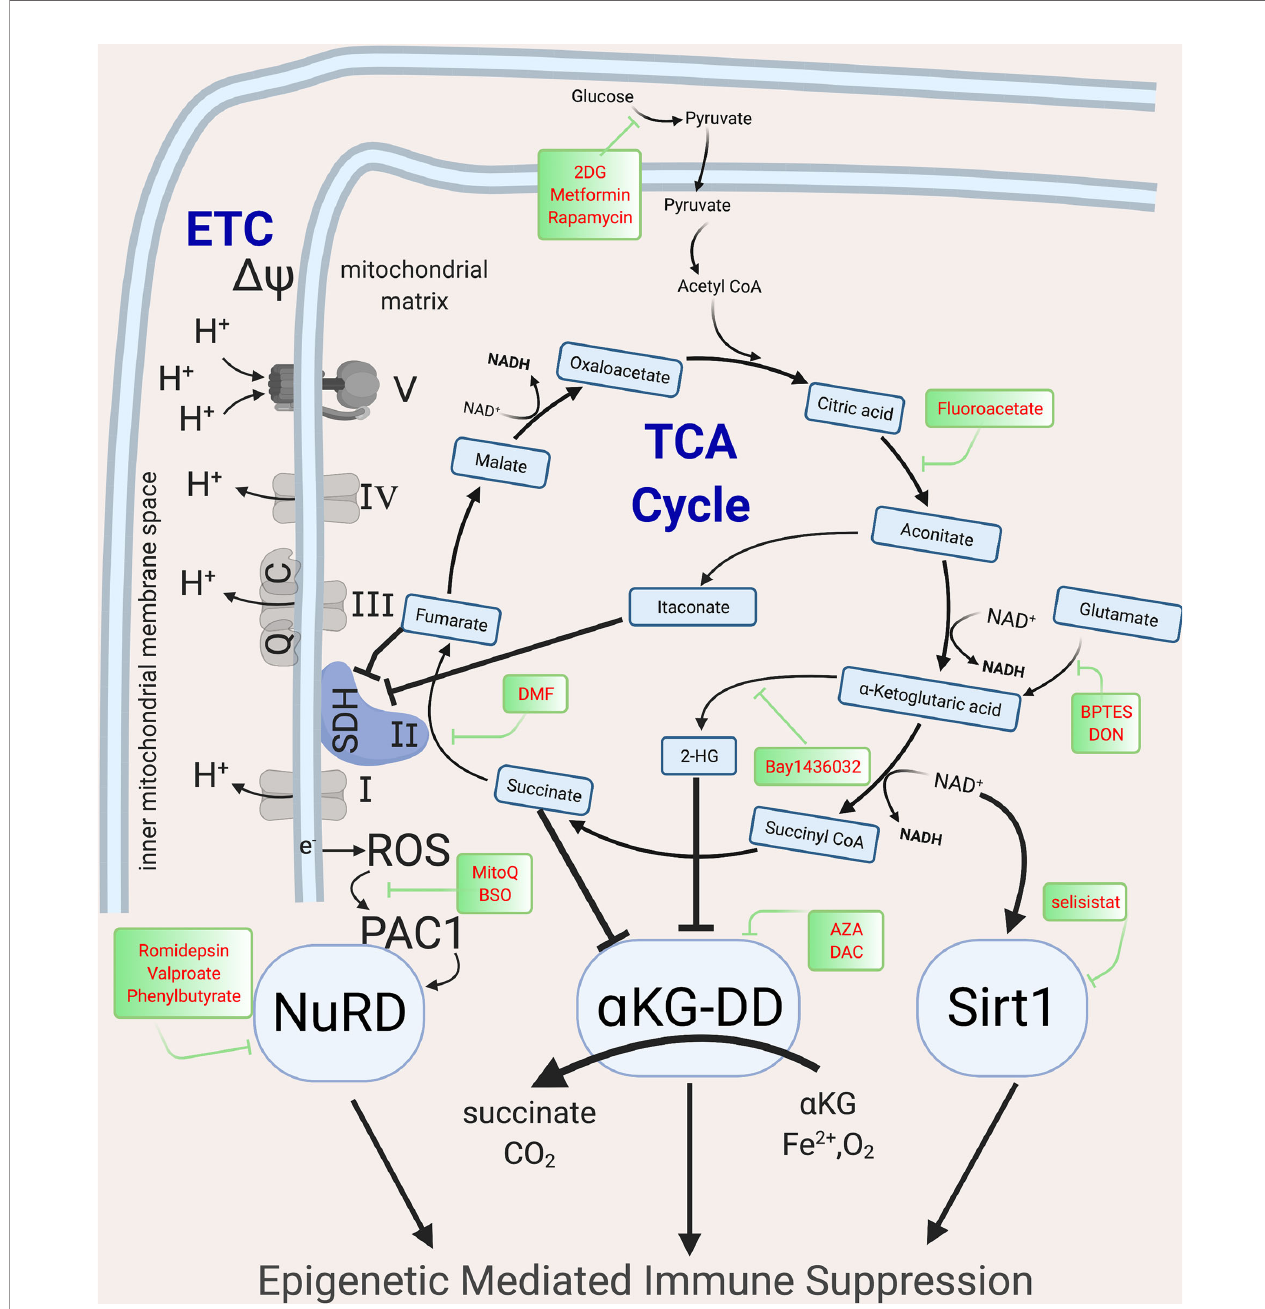
FIGURE 3 | Metabolic intermediates of the TCA cycle guide epigenetic changes that inhibit host immunity. The TCA cycle metabolites act as co-factor for major epigenetic enzymes that shape the epigenomic landscape post infection via three overlapping and redundant major metabolic-epigenetic rheostats (RST). RST1: NAD+: NADH-SIRT: Dependent on the level of NAD+ in the cell, Sirtuins, which are histone deacetylases, can remove acetyl groups and lead to immune suppression; RST2: Succinate- a KG- a KGDD: Dependent on the levels of a − ketoglutarate and succinate (which along with fumarate, malate and Itaconate acts as inhibitors of KGDDs), leads to the activation/inhibition of a family of enzyme dioxygenases which regulate the DNA methylation levels by methylating (via DNMTs) and demethylate (via KDM, JMJD and TET) the DNA; RST3: ROS-PAC1-NuRD: guided by the activation of the ETC, which leads to electron leak and induction of ROS and activation of NuRD, which is multiprotein complex guiding DNA methylation and chromatin accessibility. The main enzymes of the TCA cycle and the ETC are shown, along with the drugs that can be used to block speci fi c enzymes and help with reversing epigenetic mediated Immune suppression. NAD, Nicotinamide adenine dinucleotide; SIRT, Sirtuins; a KGDD, a − ketoglutarate-dependent-dioxygenases; DNMT, DNA methyl transferase; KDM, Histone demethylase; JMJD, Jumonji domain containing protein; ROS, reactive oxygen species; PAC1, Phosphatase of activated cells 1; NuRD, Nucleosome Remodeling and DNA methylation complex; TCA, Tri-carboxylic acid cycle; ETC, Electron transport chain. Created with